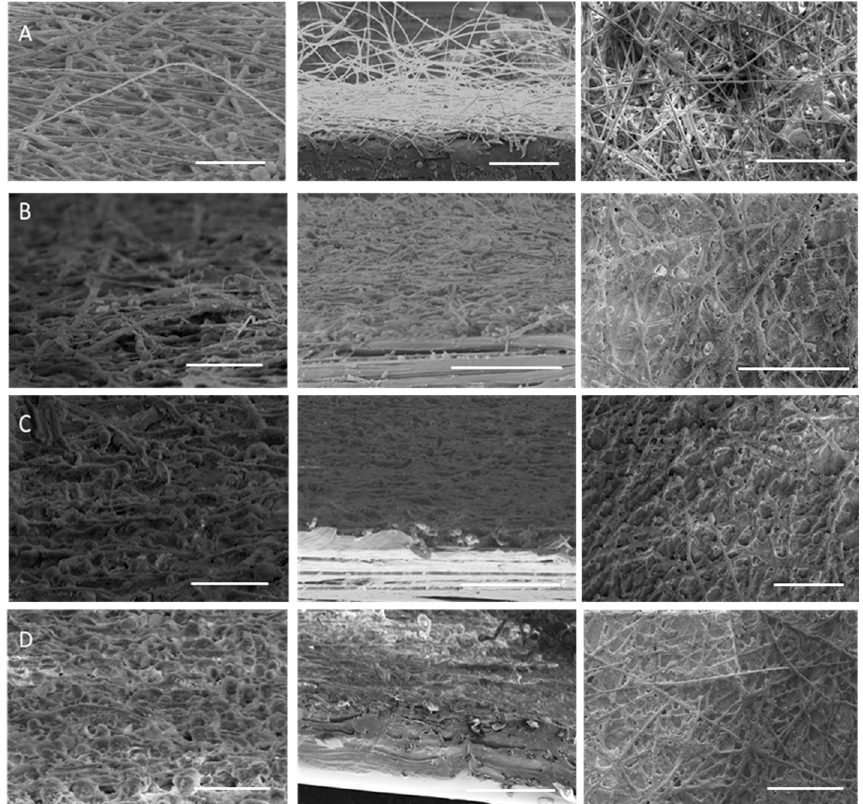
Figure 7. Field emission scanning electron microscope (FESEM) micrographs of the cross-section (left and middle columns) and top views (right column) of polyethylene terephthalate (PET)/polylactide (PLA)/silica (SiO 2 ) films: ( A ) Without annealing; ( B ) Annealed at 150 °C; ( C ) Annealed at 160 °C; ( D ) Annealed at 170 °C. The annealing time was 15 s in all samples and scale bars are 50 µm (left column) and 100 µm (middle and right columns).